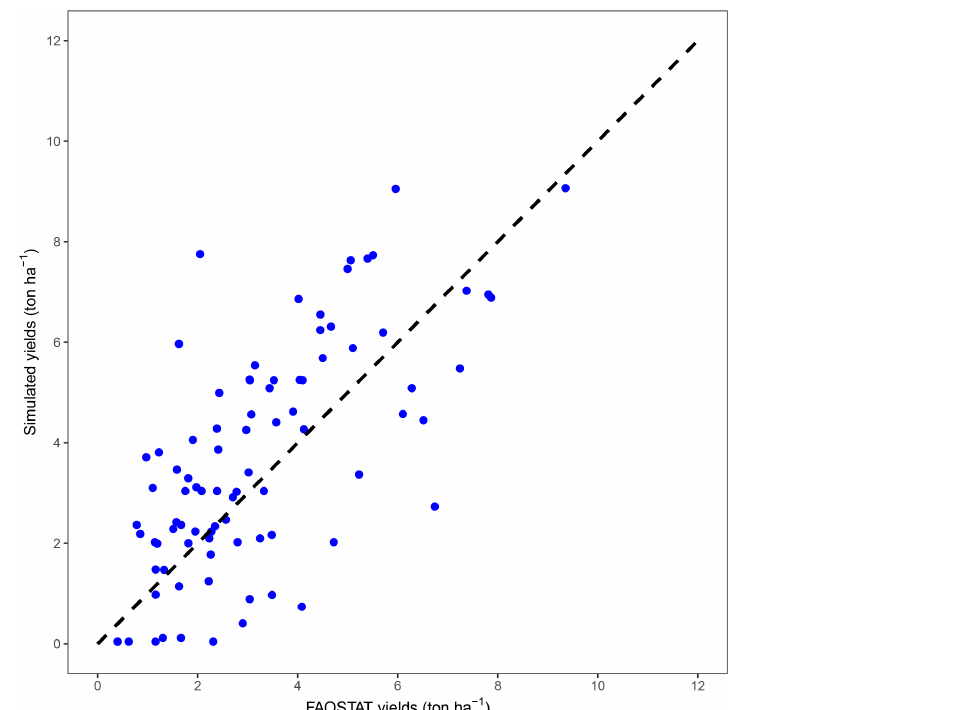
Figure B1. Comparison between the country-specific simulated yields and yield statistics (FAOSTAT, 2020). The dashed line is the 1 : 1